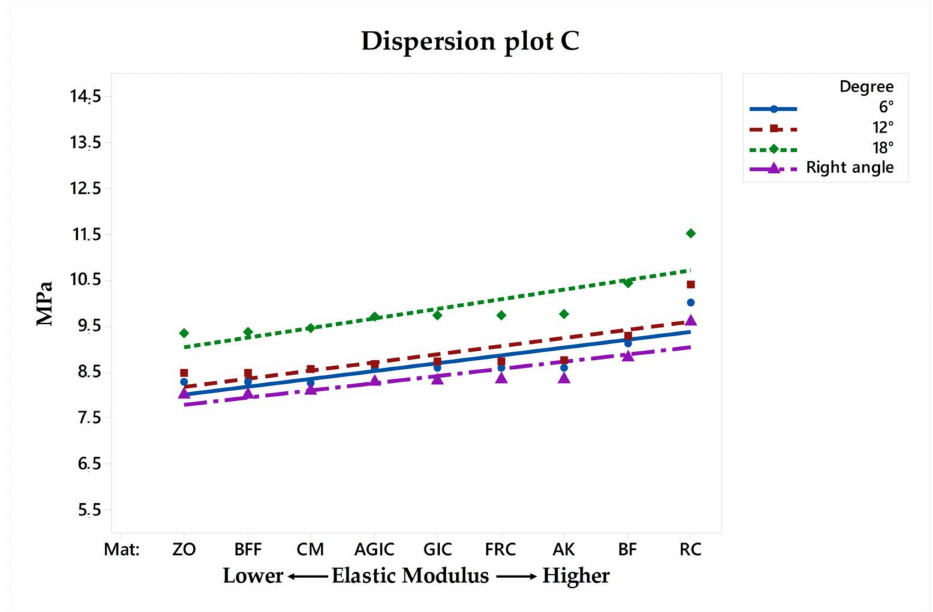
Figure 6. Dispersion plot according to the filling material elastic moduli and stress peaks recorded in the tooth adhesive